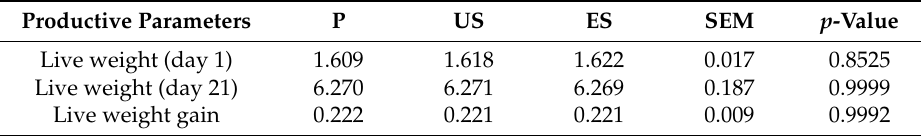
Table 1. Mean and standard error of mean (SEM) of body weight and average daily gain of piglets subjected to different iron supplementation protocols at the beginning (day 1) and at the end of the experiment (day